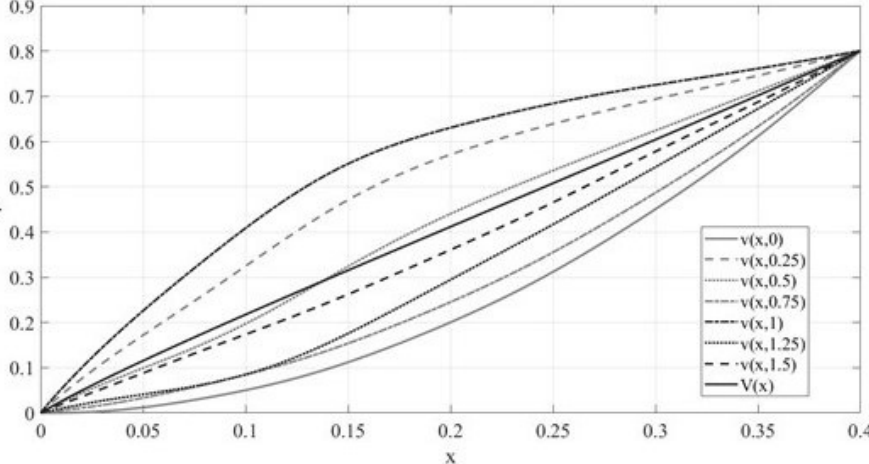
Figure 5. The graphs of the sections of the function ˆ v ( x , t ) at the time t 0 = 0; t 1 = 0.25; t 2 = 0.5; t 3 = 0.75; t 4 = 1; t 5 = 1.25; t 6 = 1.5 and limit state-function V ( x ) in the conditions of Example 3.